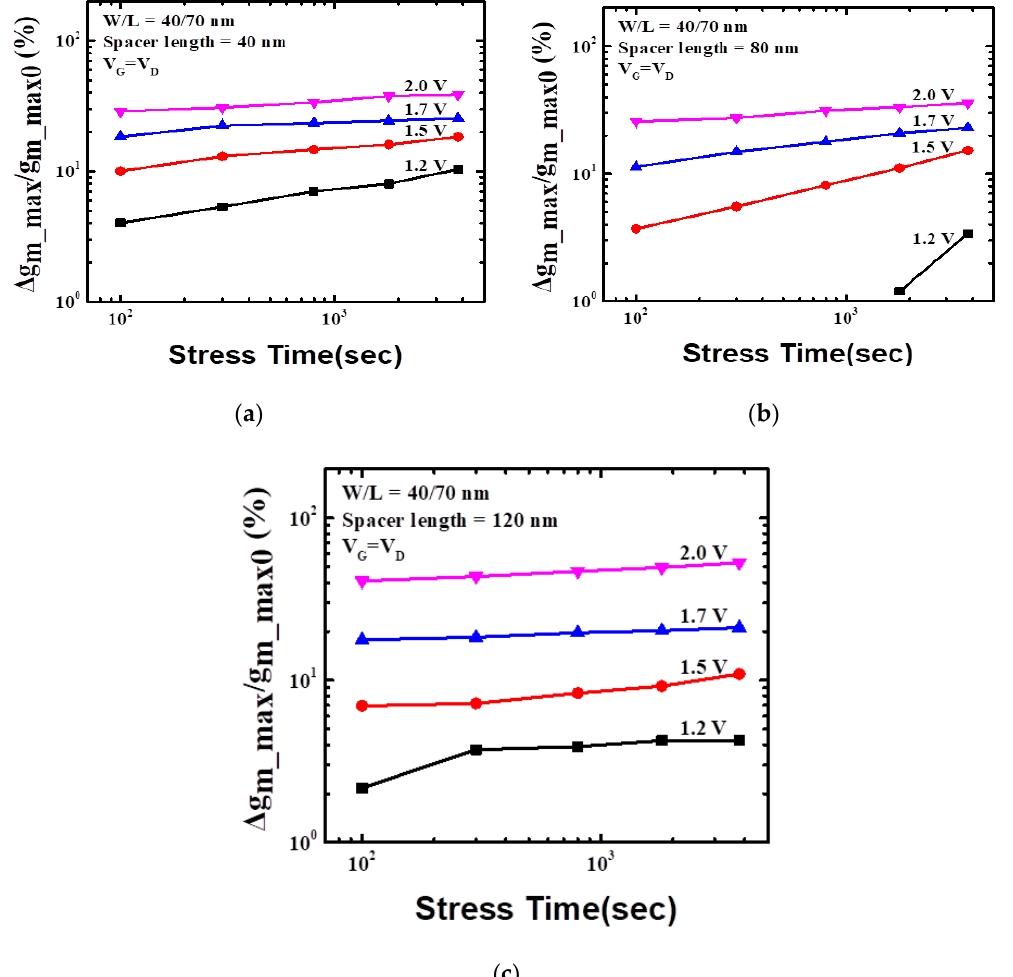
Figure 5. Transconductance degradation for different spacer lengths under the stress conditions of: ( a ) LSD = 40 nm; ( b ) LSD = 80 nm; and ( c ) LSD = 120 nm